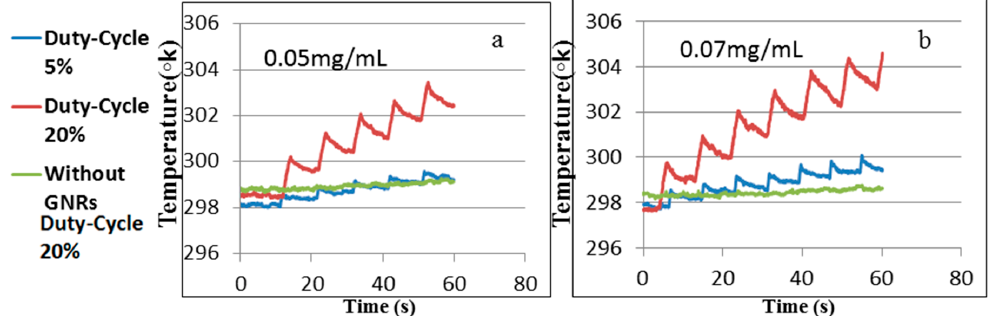
Figure 6. Temperature change as a function of time modulated by laser illumination for two different GNR concentrations: ( a ) 0.05 mg/mL; and ( b ) 0.07 mg/mL.